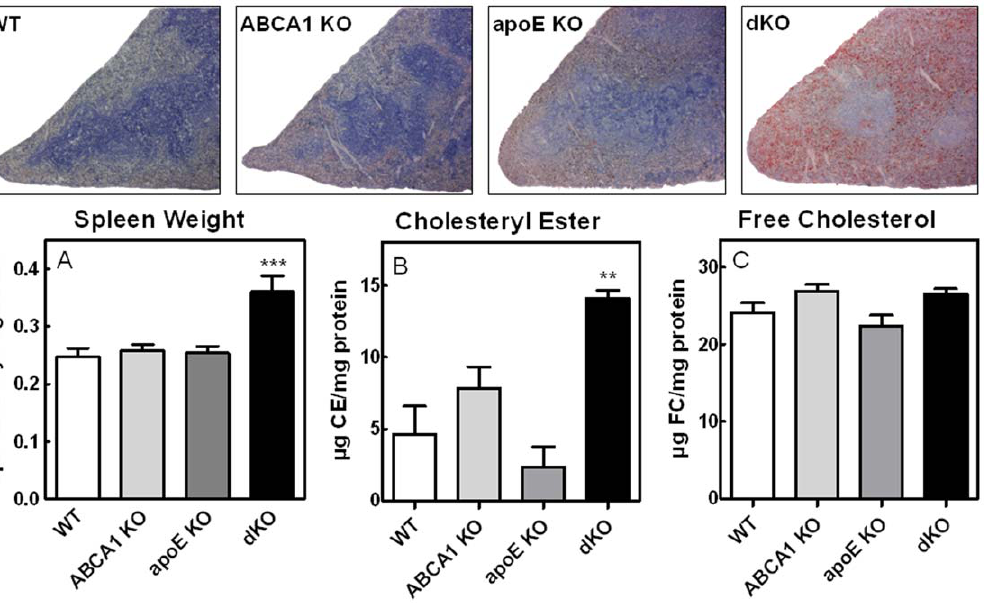
Figure 4. Increased CE content in enlarged spleens from ABCA1/apoE dKO transplanted LDLr KO mice. Representative cross sections of spleens from the bone marrow transplanted LDLr KO mice stained with oil red-O for the detection of neutral lipids and counterstained with hematoxylin (magnification 50 6 ; upper panels). Spleen weight to bodyweight ratio is increased in ABCA1/apoE dKO transplanted LDLr KO mice (A). Values represent the means of n $ 11 mice 6 SEM per group. Quantification of cholesteryl ester (CE) and free cholesterol (FC) content of spleens (B and C, respectively). Values represent the means of n $ 5 mice 6 SEM per group. **p , 0.01, ***p , 0.001 as compared to WT transplanted controls.